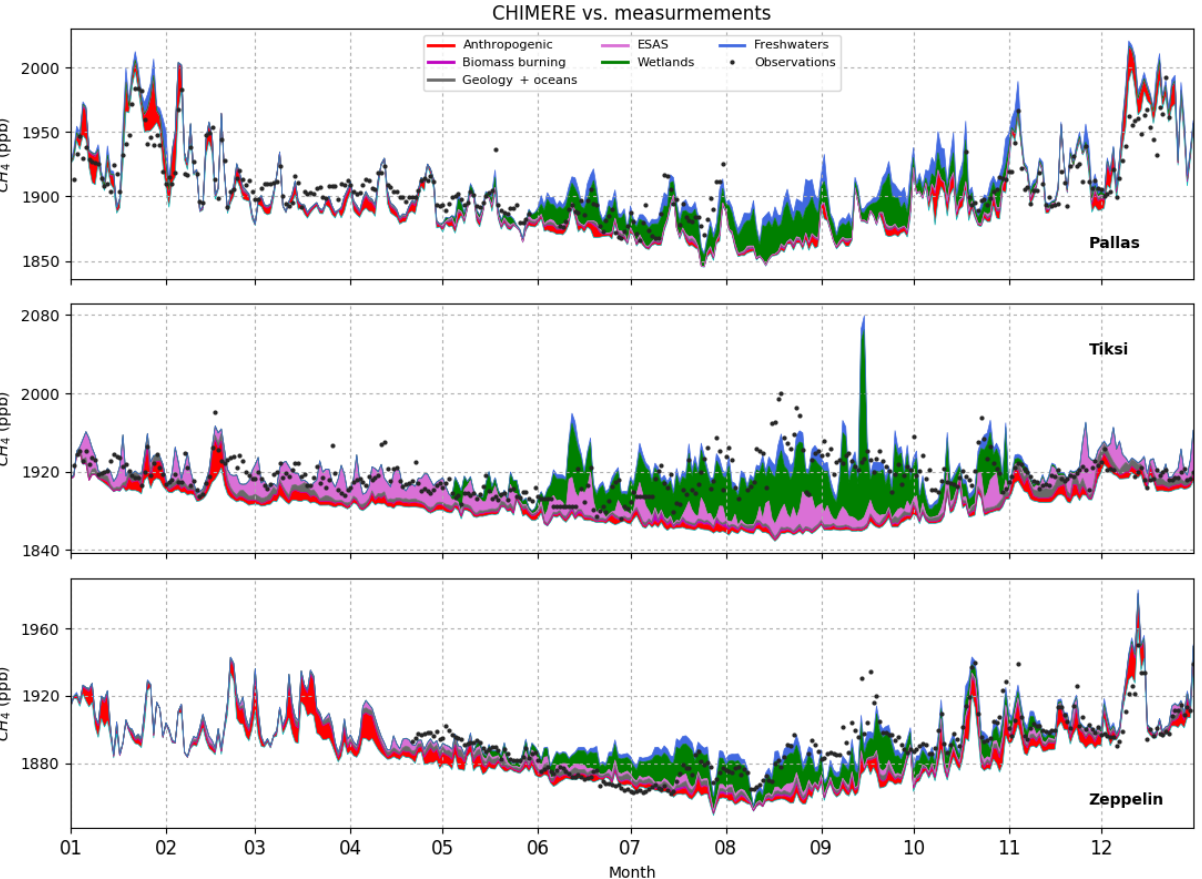
Figure 7. Same as Fig. 6, for Pallas, Tiksi, and Zeppelin.